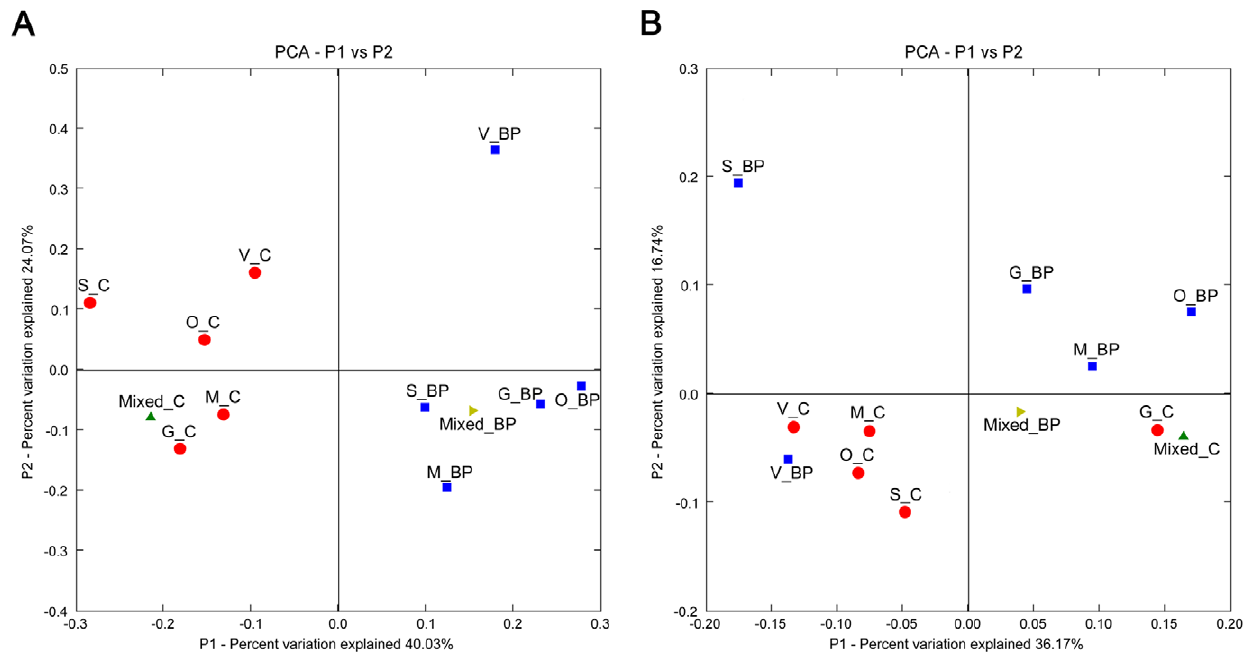
Figure 5. UniFrac analysis of V3 16S sequences ( Firmicutes and Fusobacteria only) from canine fecal samples. Principal Component Analysis scatter plots of individual samples (control = red circles; beet pulp = blue squares) combined with pooled samples (pooled control = green triangle; pooled beet pulp = gold triangle). ( A ) Clustering within the phylum Firmicutes . ( B ) Clustering within the phylum Fusobacteria .